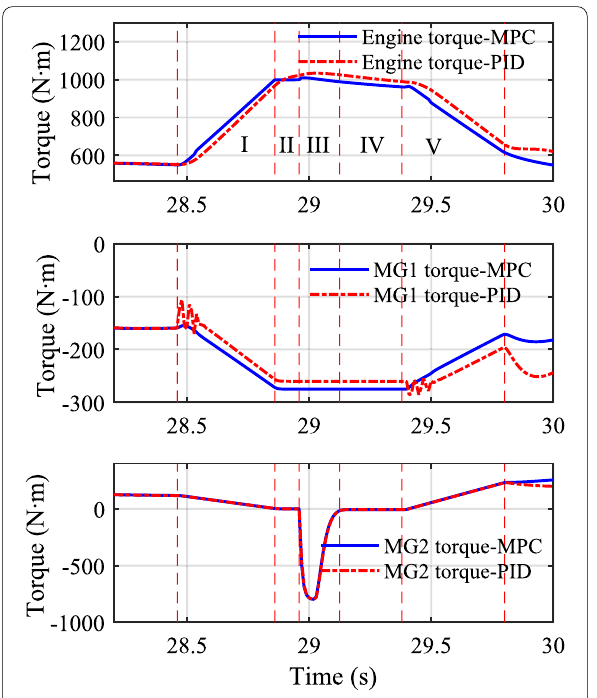
Figure 9 Driving torque and system